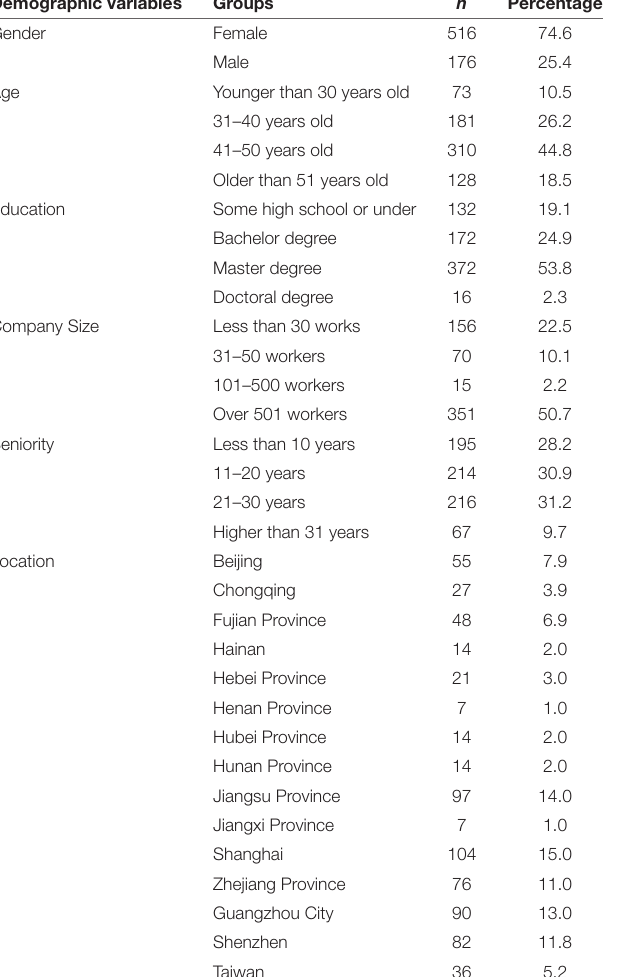
TABLE 2 | Descriptive summary of sample distribution analysis ( n = 692). Demographic variables